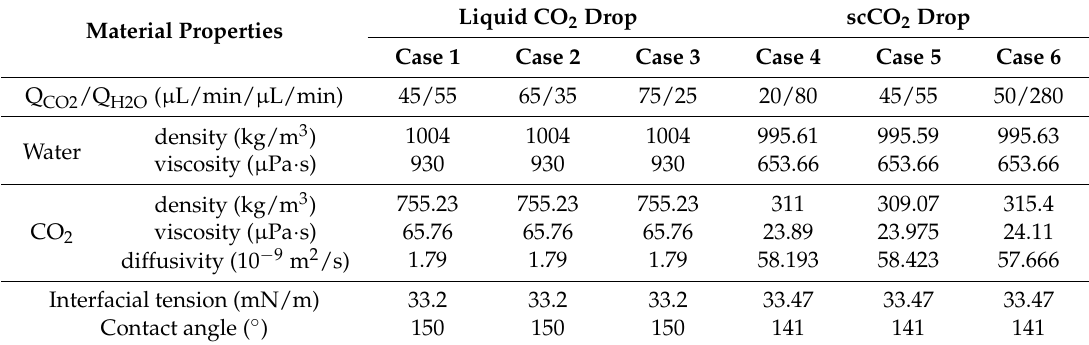
Table 2. Material properties of the applied water and CO 2